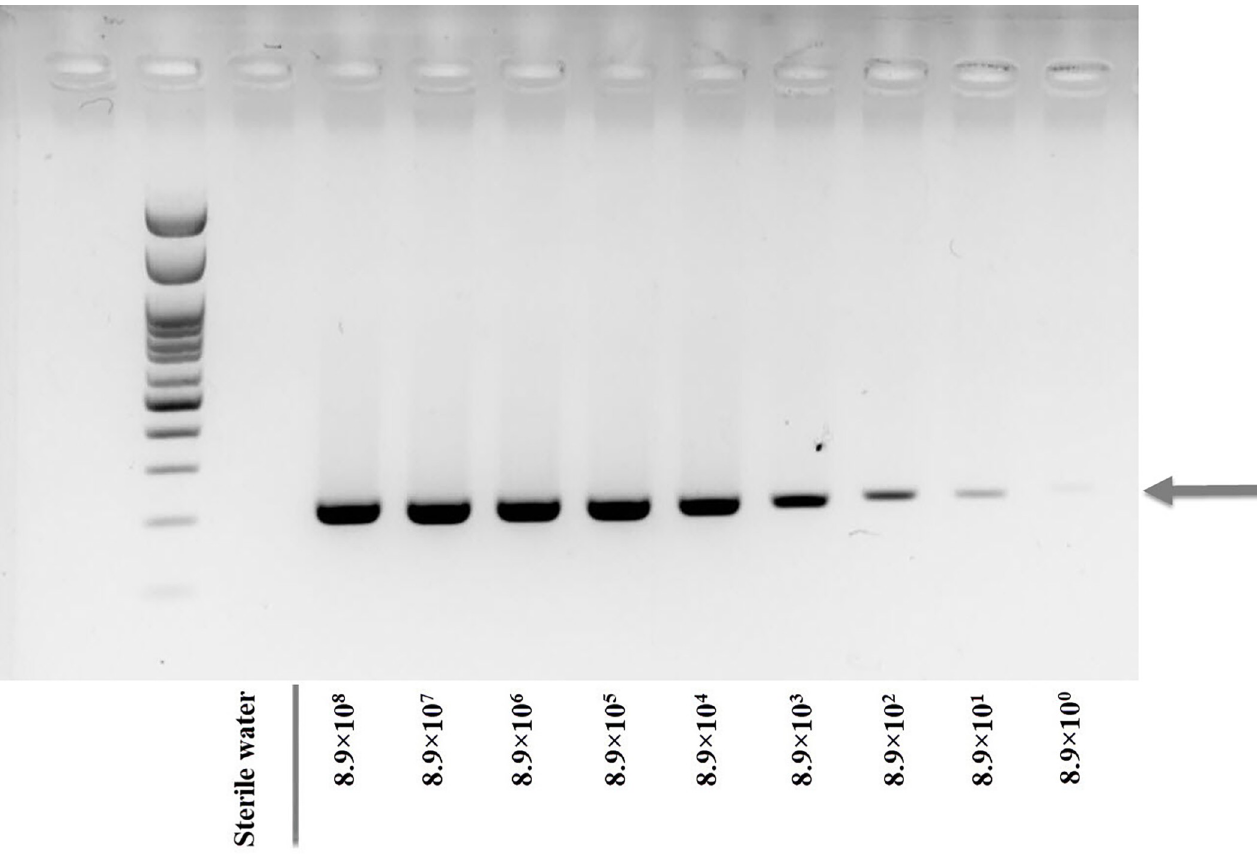
Fig 2. Sensitivity determination of PCR-GE using primers Cla-F3 and Cla-B3. The first left lane was OneMARK 100 DNA ladder (Bio-Helix). The sensitivity assay included sterile water (negative control) and 8.9 × 10 8 to 8.9 × 10˚ copy numbers (1.0 ng to 0.01 fg) of omp from C . Liberibacter asiaticus.